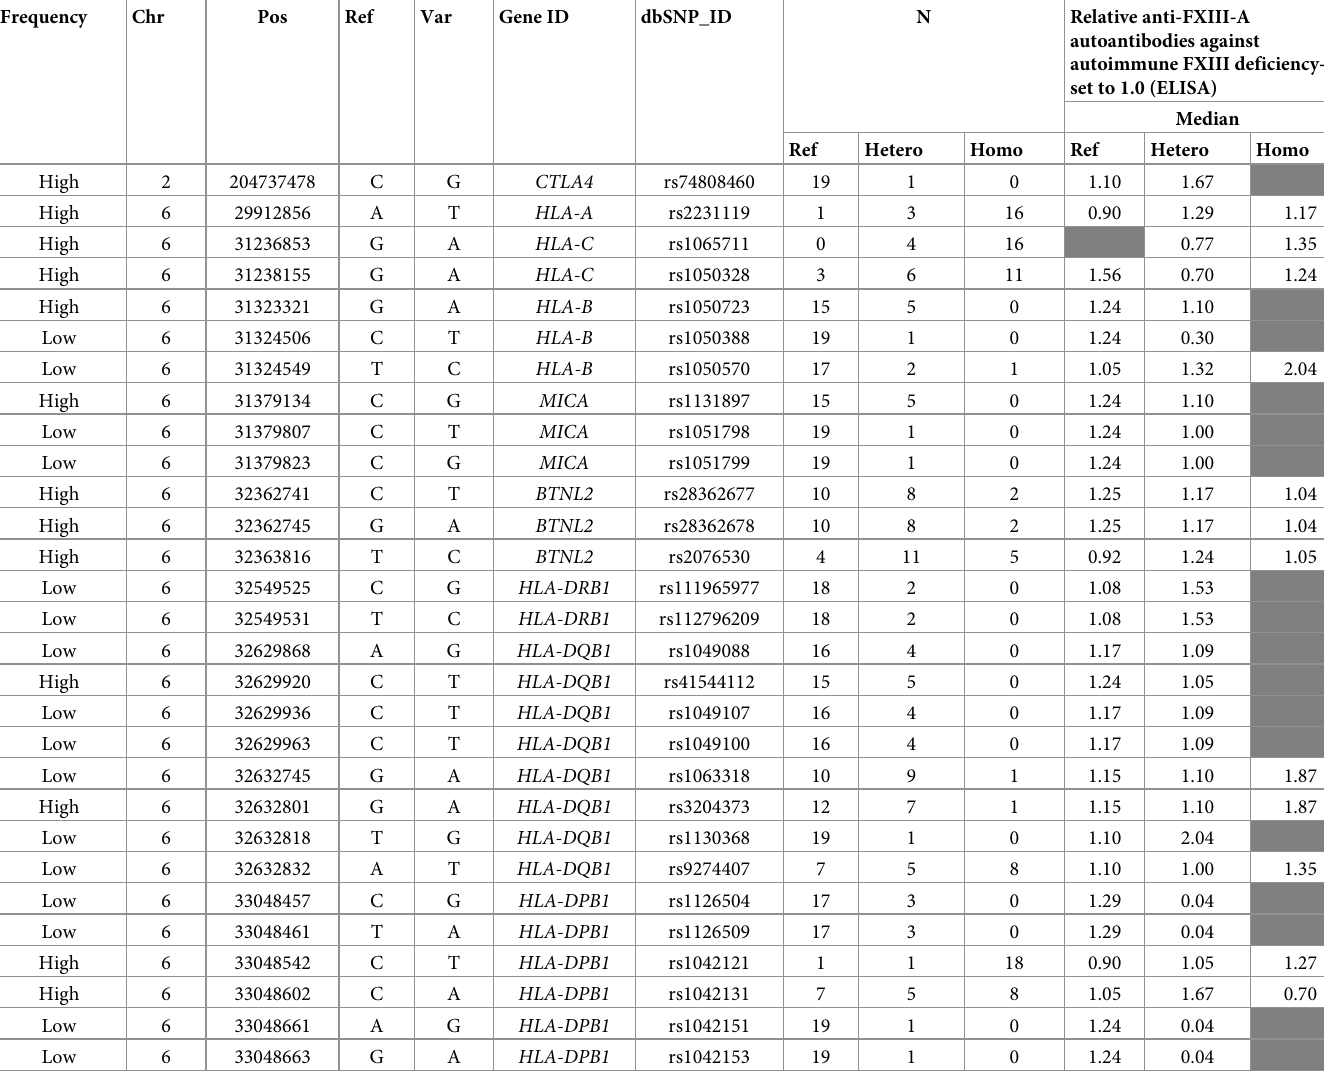
Table 4. Anti-FXIII-A autoantibodies measured by ELISA in each genotypes of MHC class I and II molecules and their associated